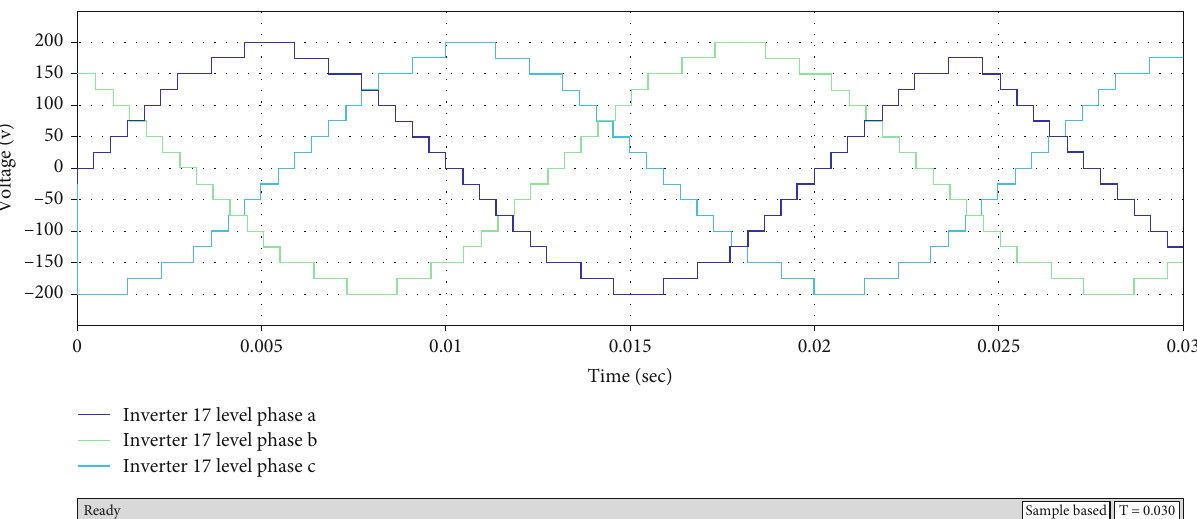
Figure 34: 3-phase 17-level MLI with t = 0 : 03